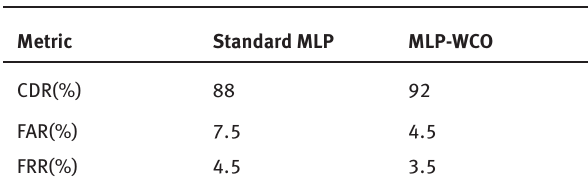
Table.1: Classification comparison of performance in the